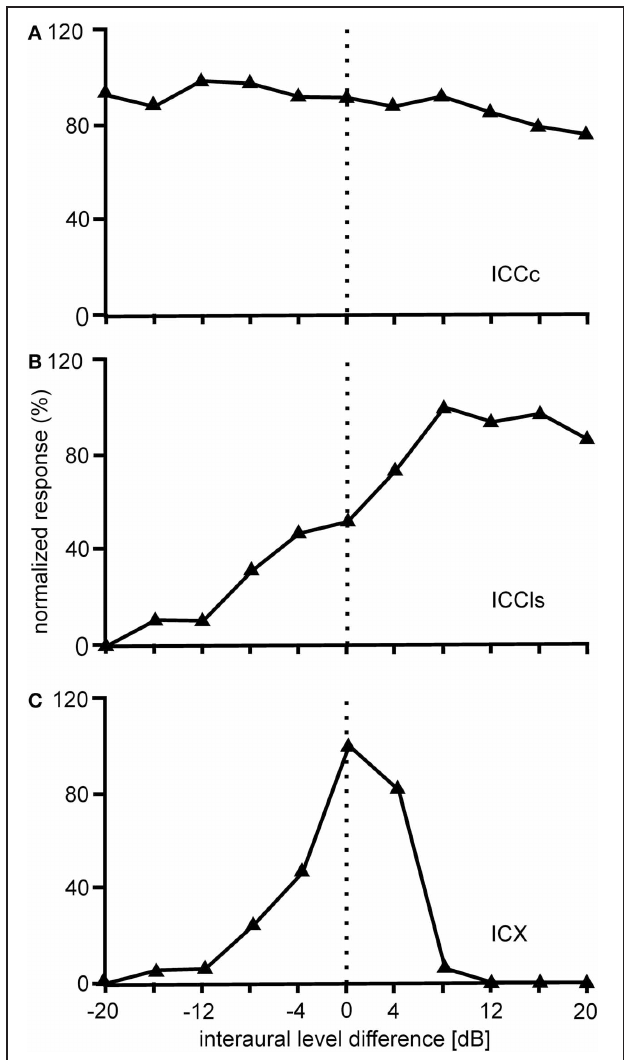
FIGURE 6 | ILD tuning. Shown are examples of the variations of the normalized responses with ILD of neurons located in different nuclei of the IC. The responses of ICCc cells do not vary with the interaural level difference (ILD) (A) . The ILD tuning of the cells in ICCls is sigmoidal (B) , while the ILD tuning in ICX is bell-shaped (C)